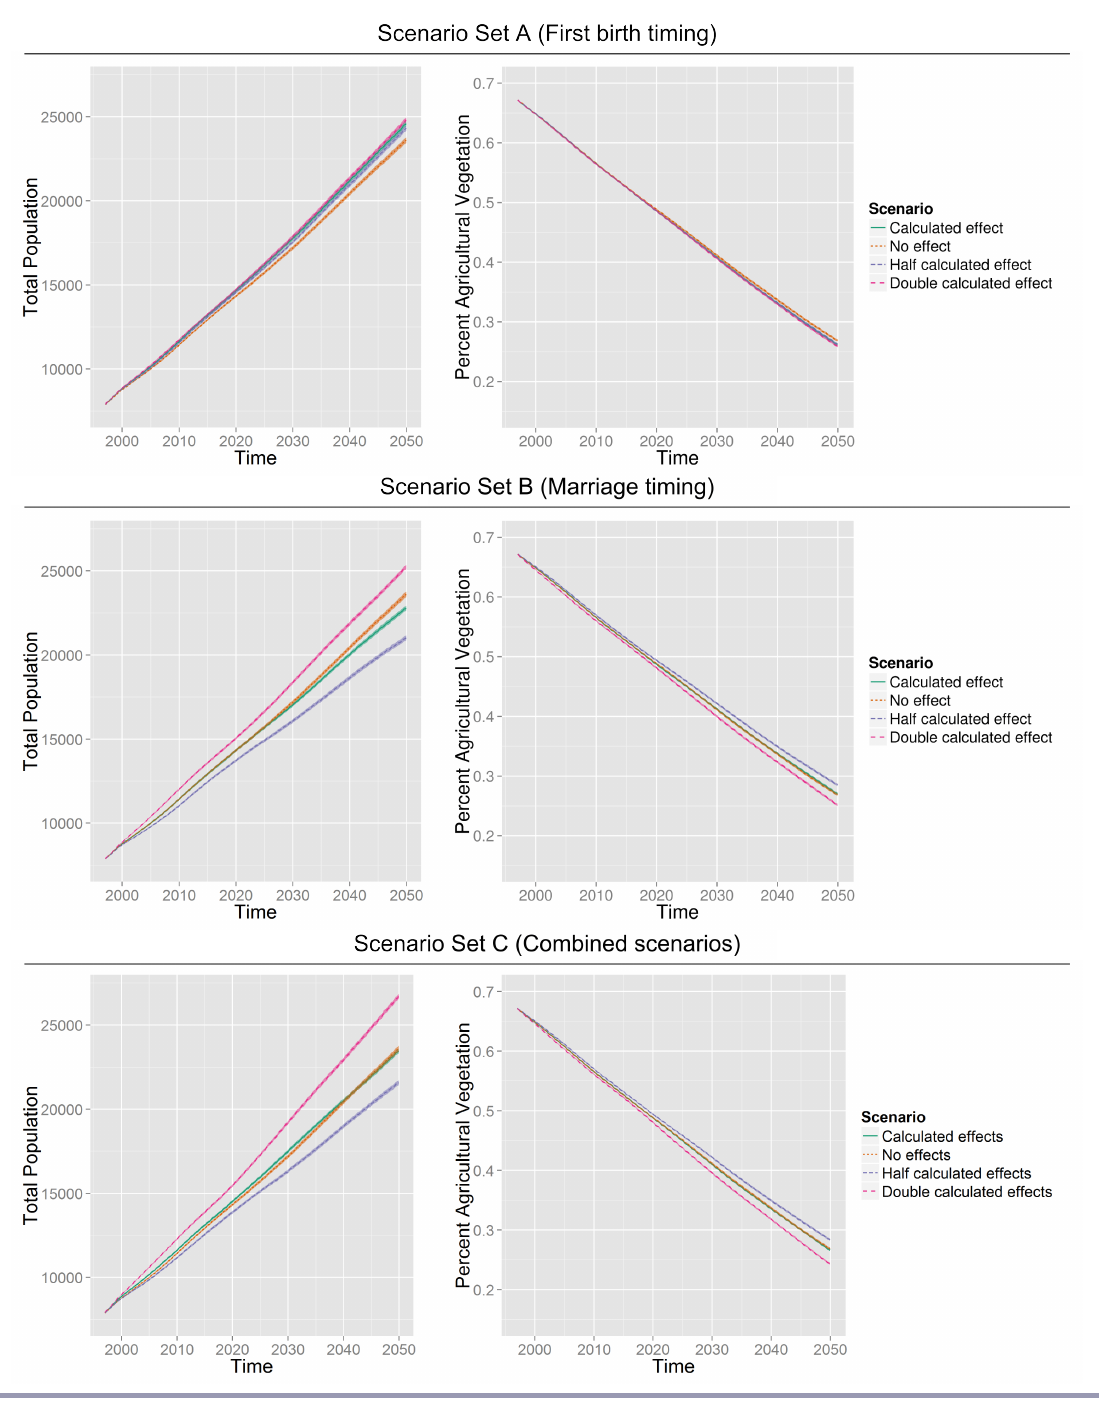
Fig. 3 . Population (left) and agricultural vegetation (right) plotted for the three sets of scenarios over a 53-year model run